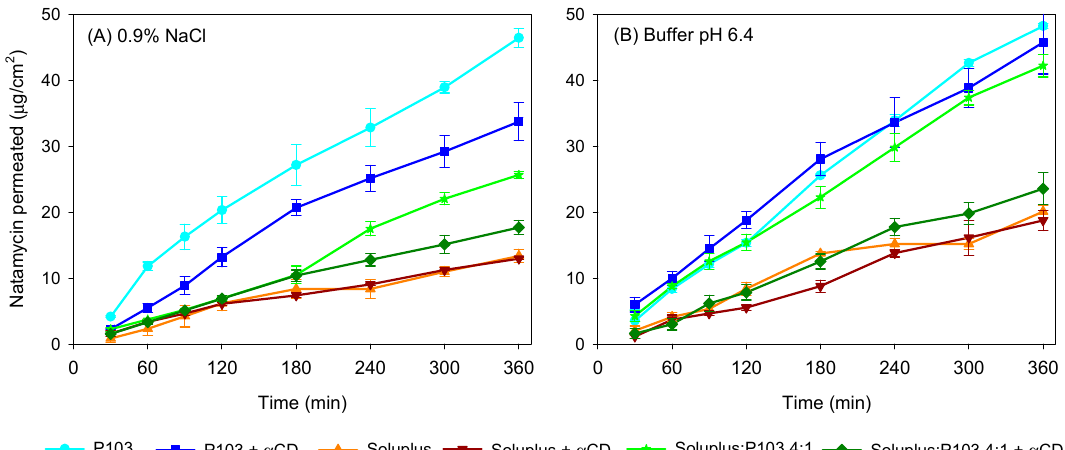
Figure 6. Natamycin diffusion test at 37 °C from Soluplus and Pluronic micelles, Soluplus:Pluronic P103 4:1 v/v mixed micelles, and poly(pseudo)rotaxanes in 0.9% NaCl (A) and pH 6.4 buffer (B). Total copolymer concentration was 10% w / v in all cases.